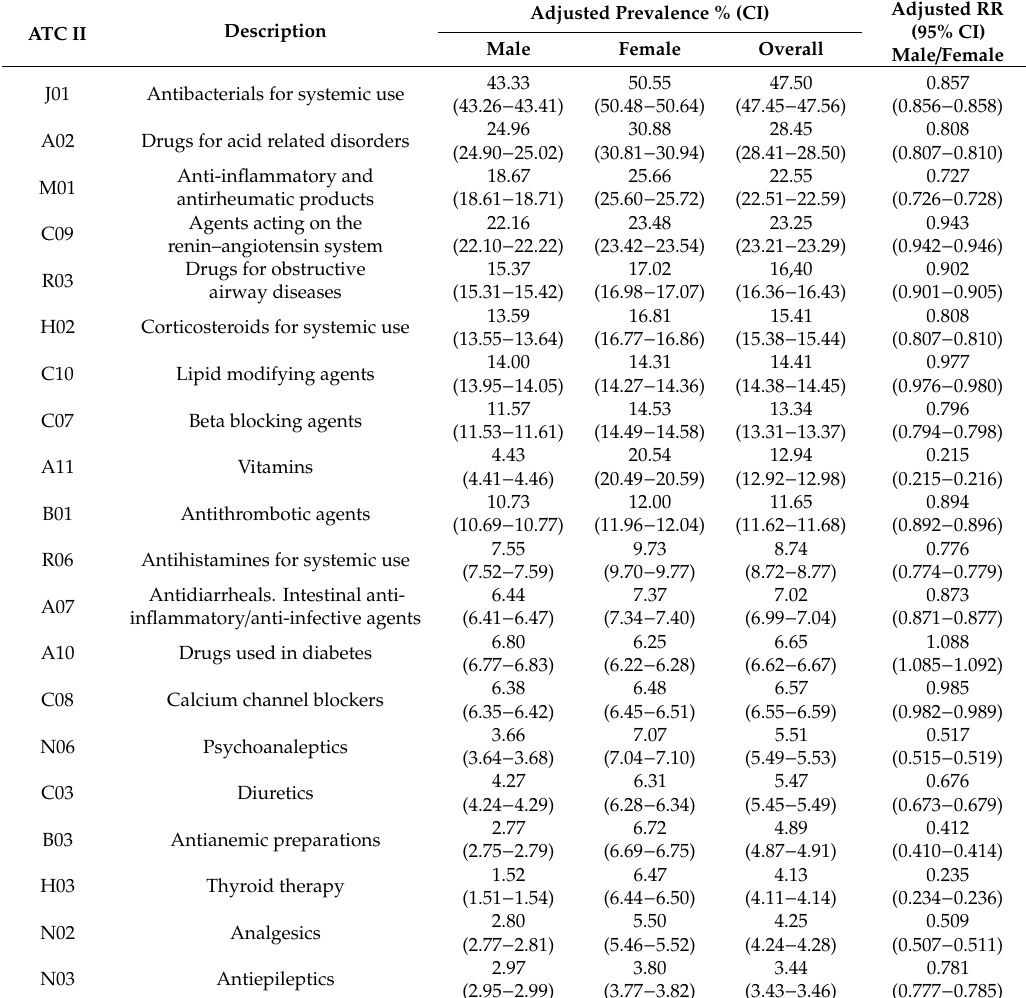
Table 2. Gender di ff erences in prevalence (%) of drug therapy (therapeutic groups—ATC II). ATC II